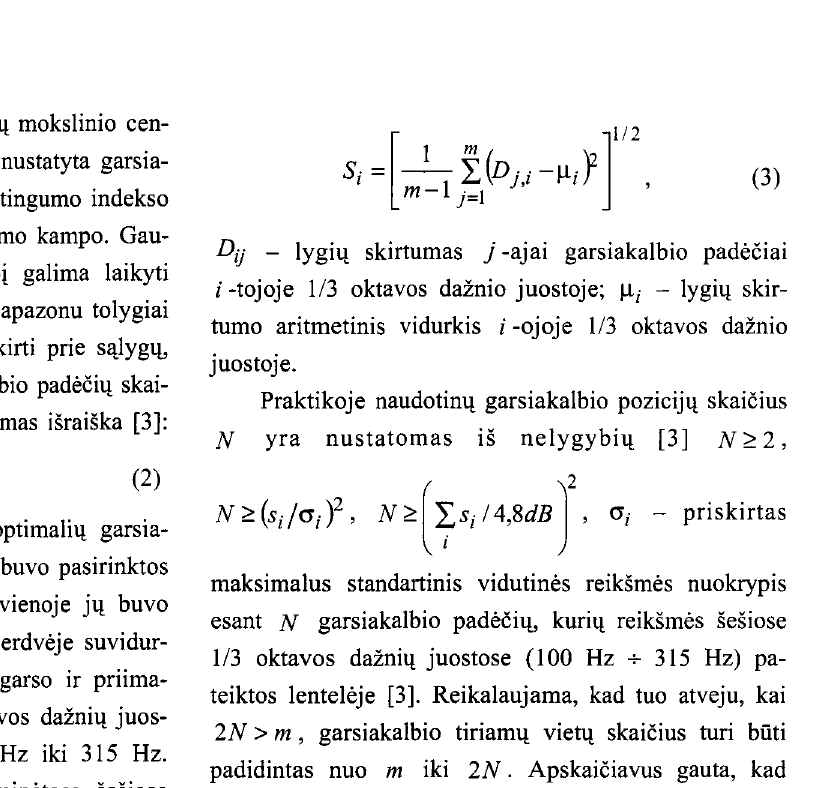
Table 1. Differences in levels Dij , dB and statistical